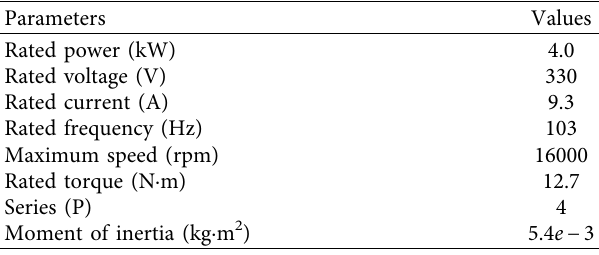
Table 1: Performance parameters of the spindle motor. Parameters